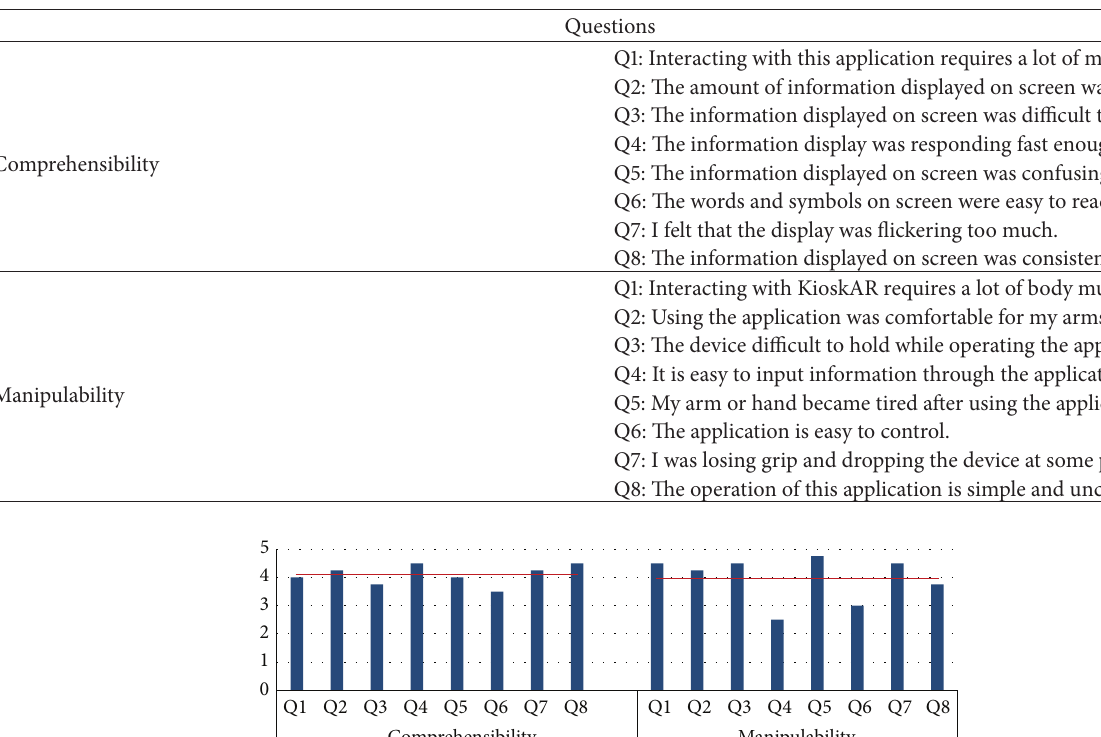
Table 2: The statements used in HARUS questionnaire to evaluate usability.